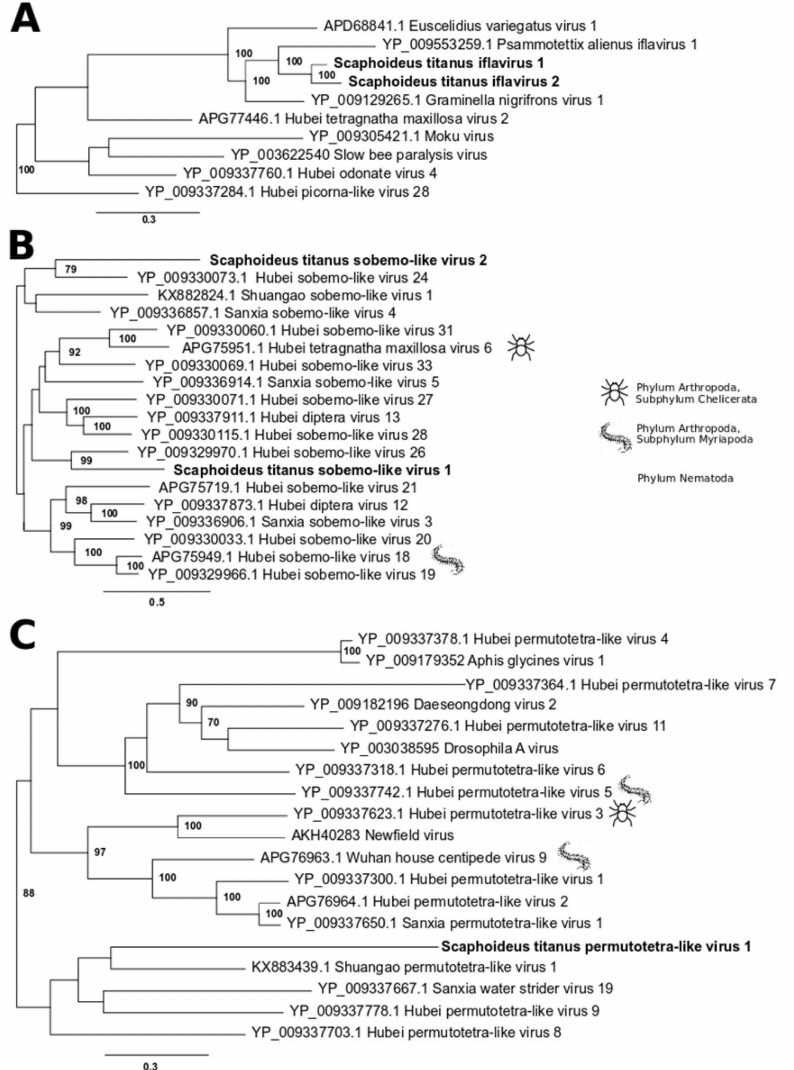
Figure 1. Maximum likelihood phylogeny of + ssRNA viruses. Putative viruses that may infect S. titanus are in bold. All the phylogenies described in this manuscript used virus sequences and nomenclature as provided by Shi et al. [28]. Tree ( A ): Scaphoideus titanus iflavirus 1 and Scaphoideus titanus iflavirus 2 within the “Iflaviridae-Secoviridae related cluster”. GenBank accession numbers of the